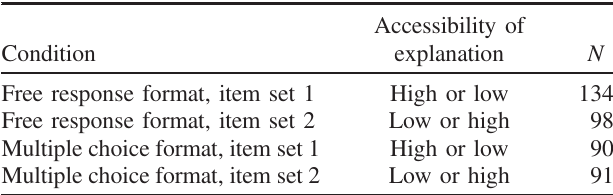
TABLE V. Experiment 2